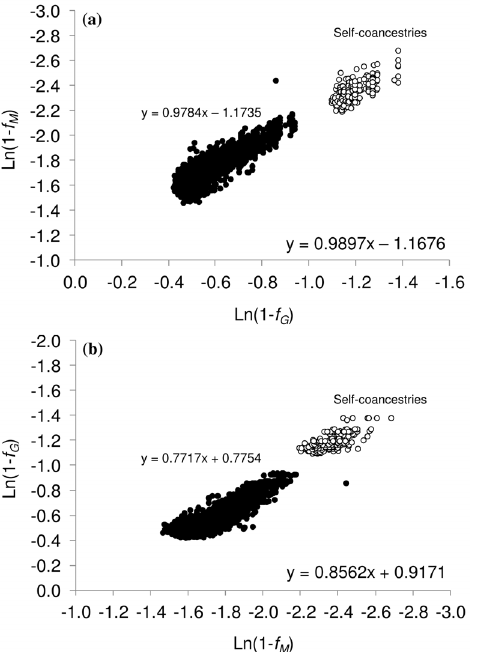
Figure 3. Predictions of SNP-based and microsatellite-based molecular coancestry ( f M ) and genealogical coancestry ( f G ). (A) Prediction of SNP-based and microsatellite-based molecular coancestry from genealogical coancestry. (B) Prediction of genealogical coancestry from both types of molecular coancestry. The dataset included only the 30 individuals with SNP and microsatellite genotypes available. The complete pedigree information was used for the estimation of genealogical coefficients. Regression equations refer to pairwise coancestries, excluding self-coancestries.